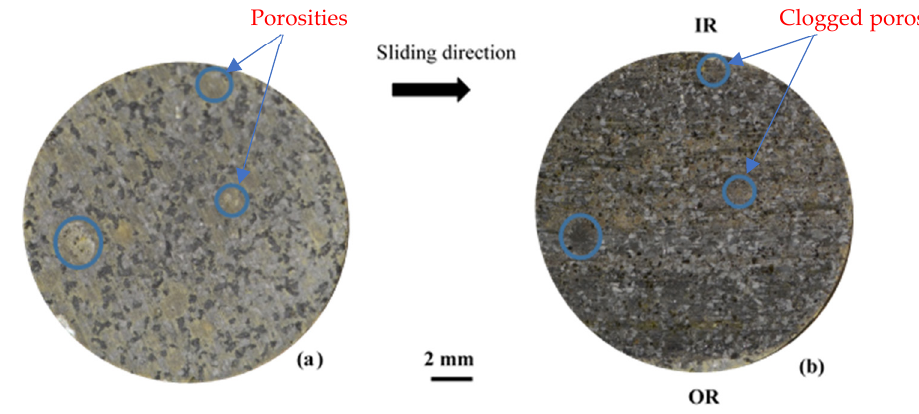
Figure 7. Photos taken before ( a ) and ( b ) after the friction for FMFS.